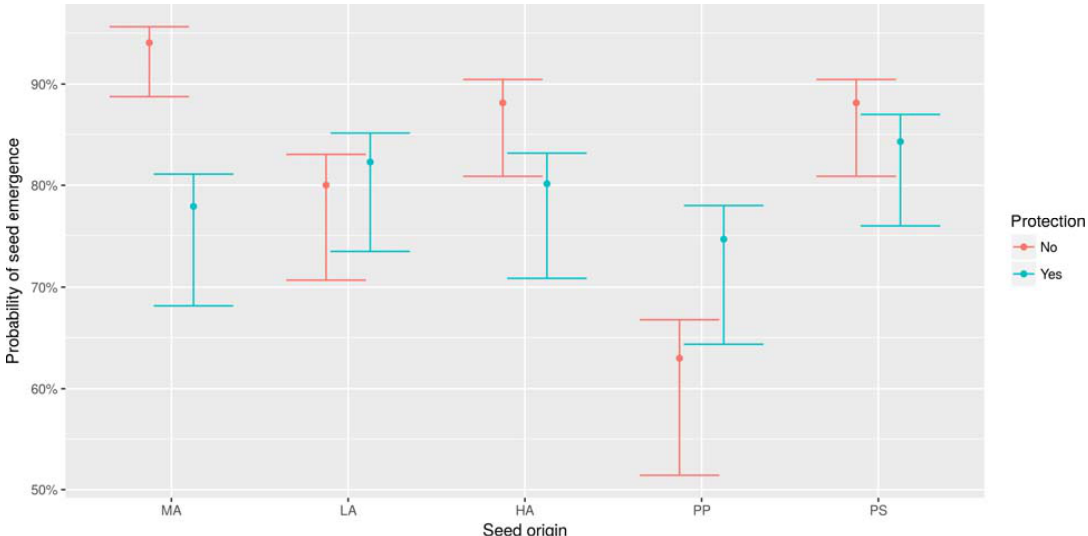
Figure 3. Probability of seed emergence for each seed origin (MA: P. nigra from typical distribution, HA: P. nigra from upland forests distribution, LA: P. nigra from lowland forests distribution, PS: P. sylvestris and PP: P. pinaster ) and protection status. The error bars indicate the 95% interval.